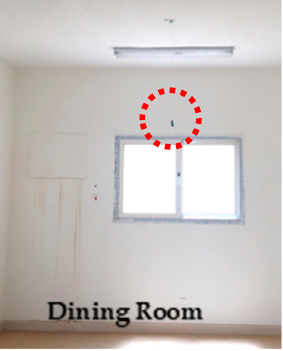
Figure 2. Photos of the installed data loggers in each room.